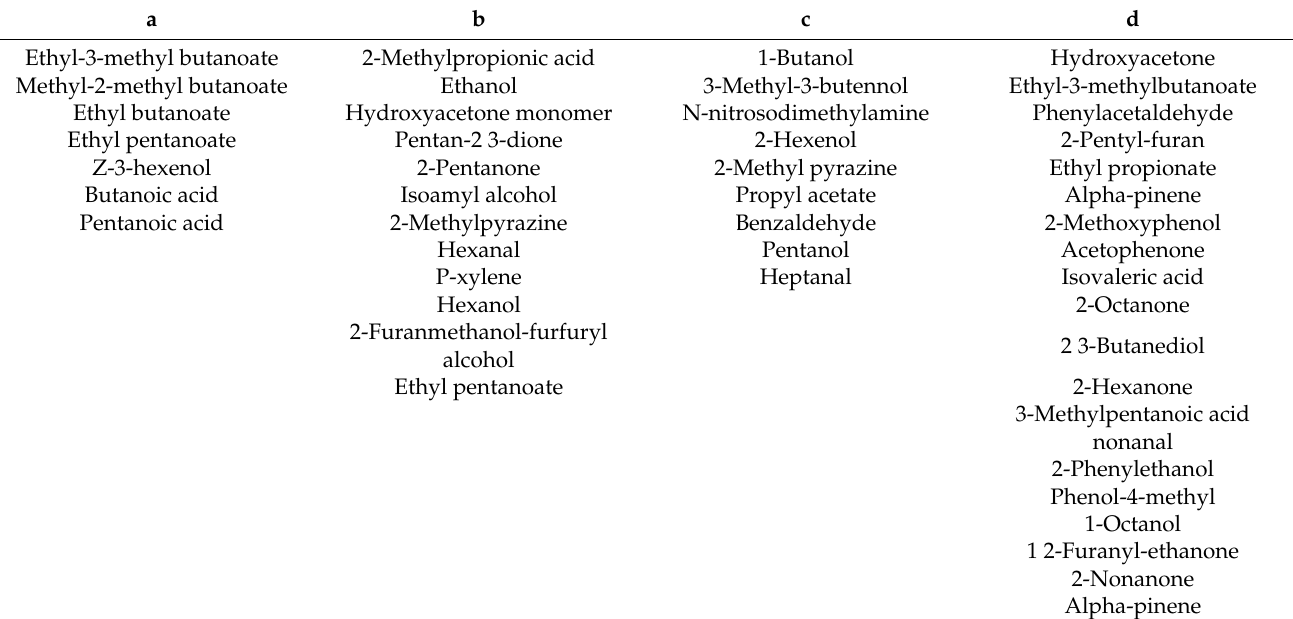
Figure 5. Fingerprint spectra (C) of volatile compounds in Daokou braised chicken at different pro- cessing stages. (Note: The numbers represent compounds which could not be accurately identified). Table 2. The names of compound in Figure 5 in regions “a, b, c and d”.